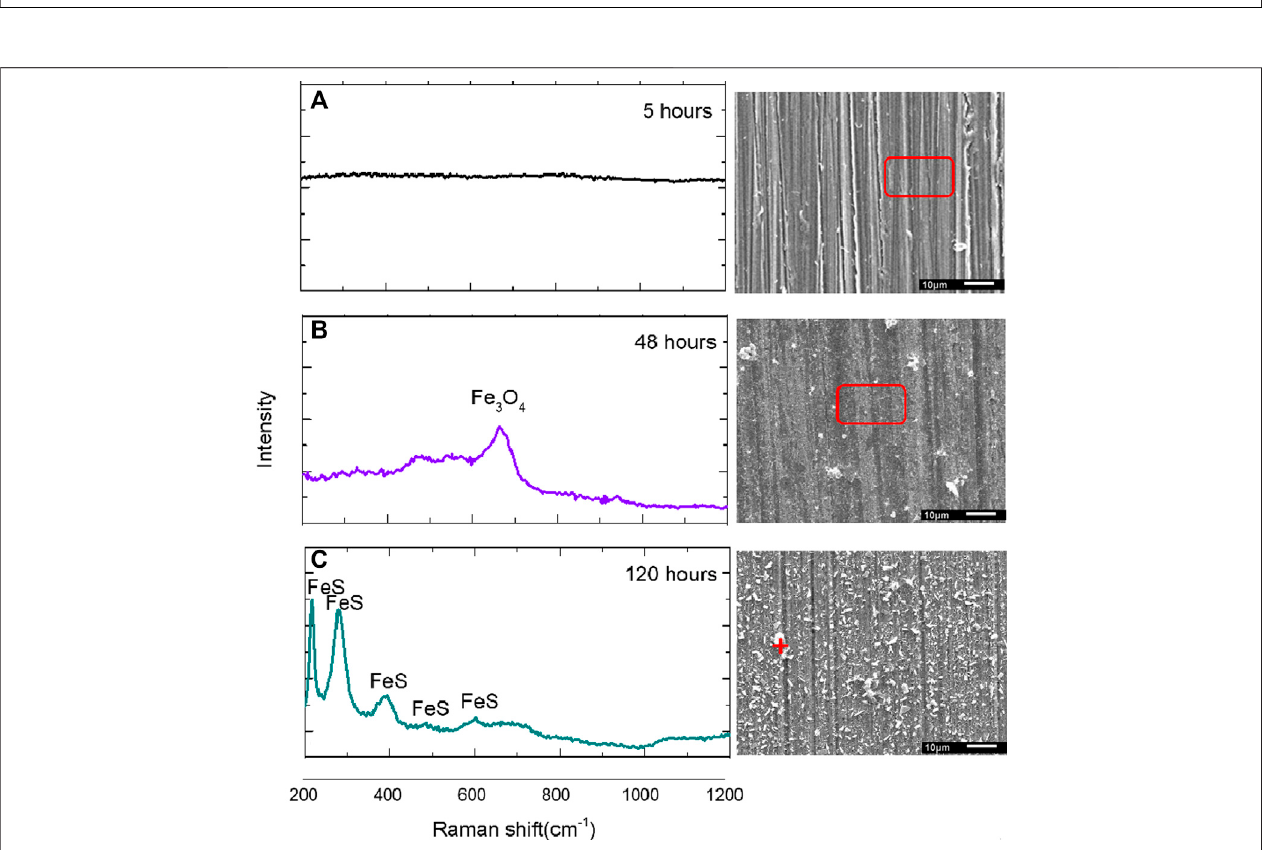
FIGURE 5 | Raman spectra of the corrosion scale formed on S13Cr SS in the formate fl uid at 180 ° C after (A) 5 h, (B) 48 h, and (C) 120 h immersion time.